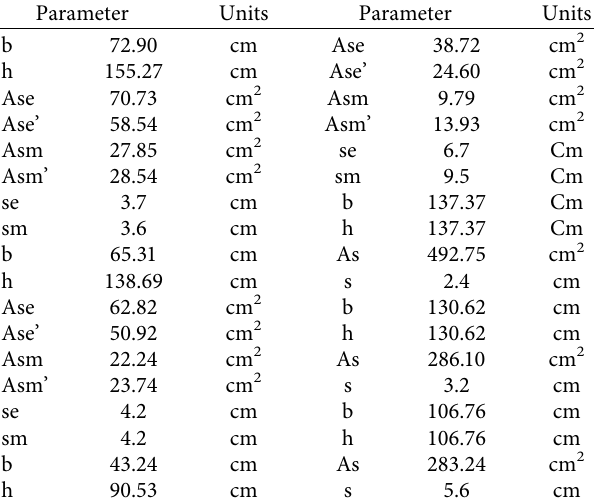
Table 4: 12-story building structural design using ANN.